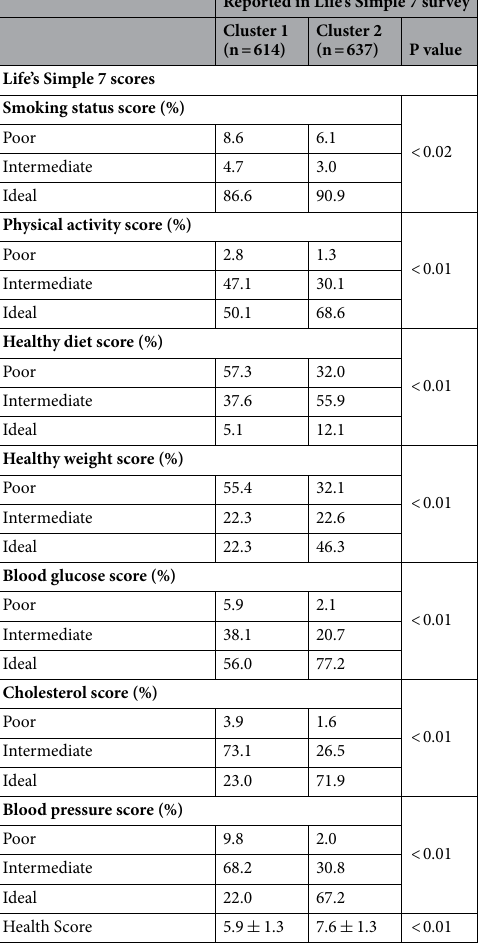
Table 4. Phenogroup Life’s Simple 7 Health Factors and Behaviors Score. Non-parametric variables were analyzed by Wilcoxon rank-sum